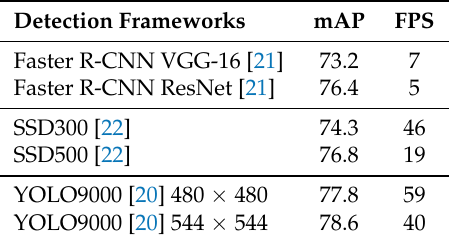
Table 1. Comparison between YOLO9000 and other methods. The higher is the mAP score, the better (source from